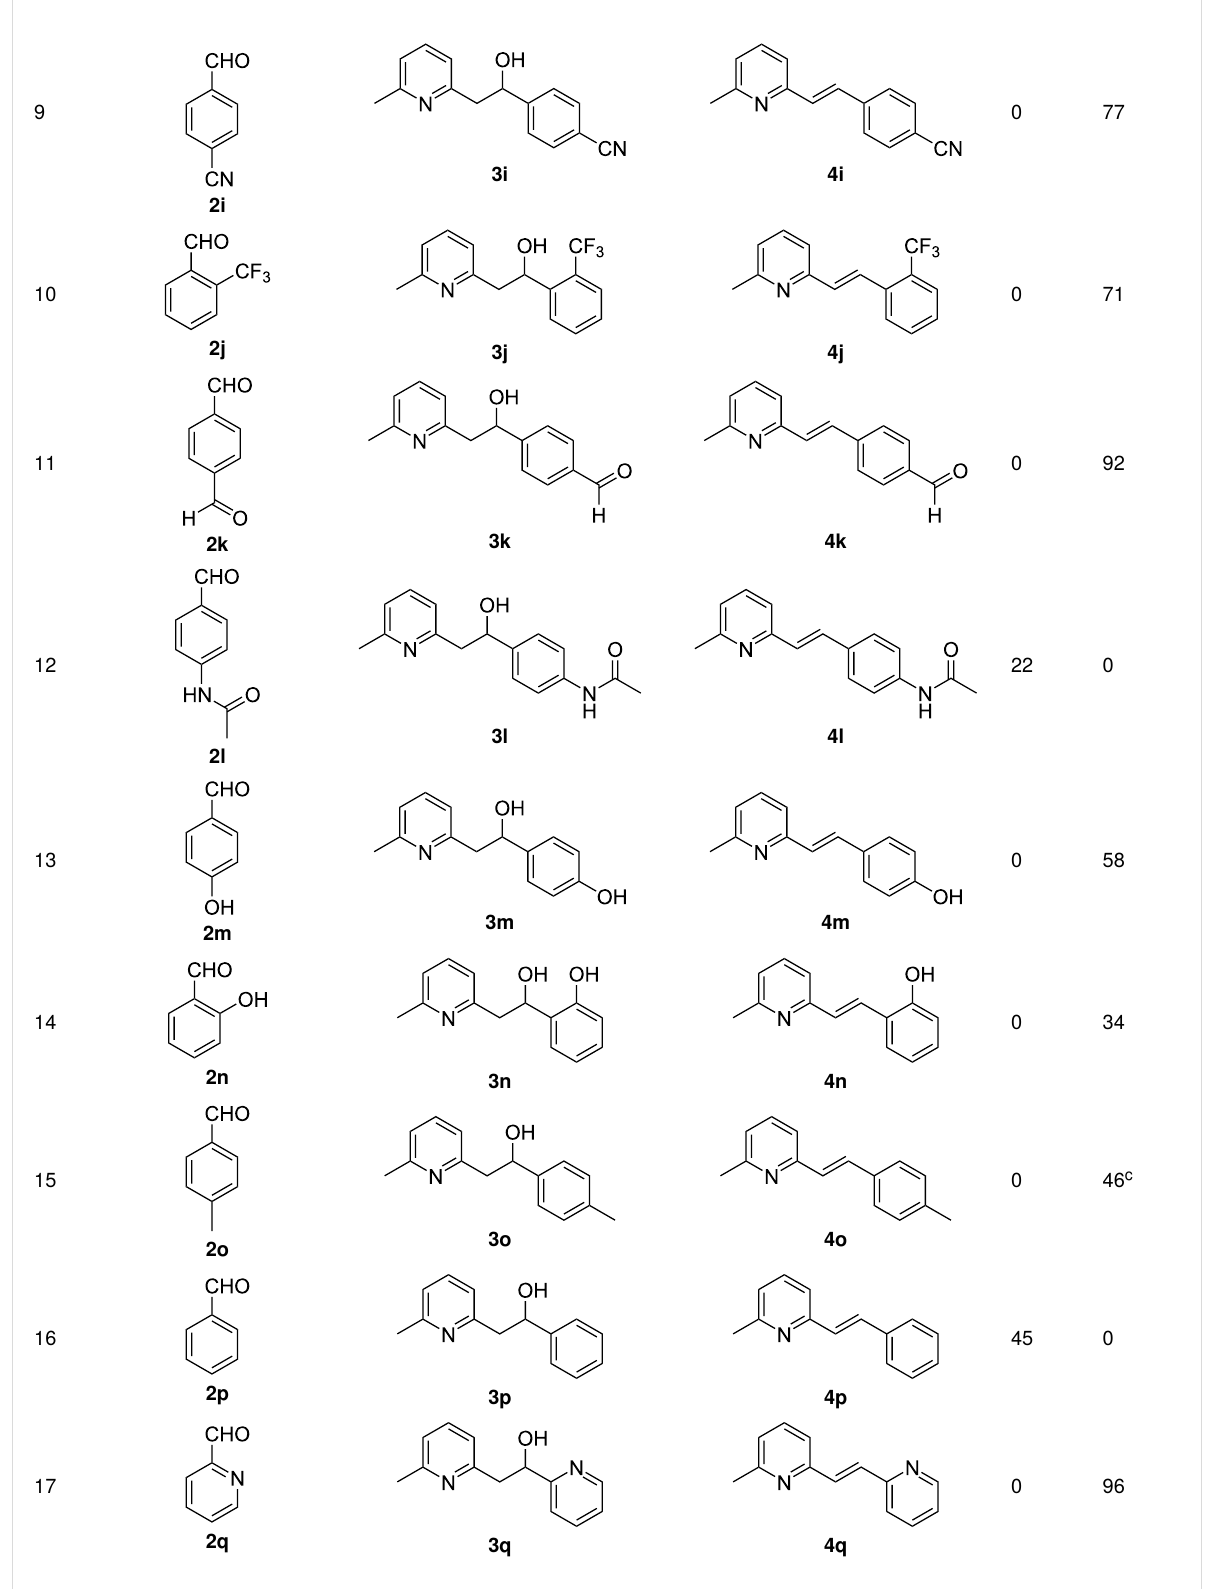
Table 2: Variation of the aldehyde component 2 . a